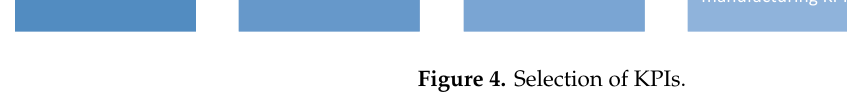
Figure 4. Selection of KPIs.